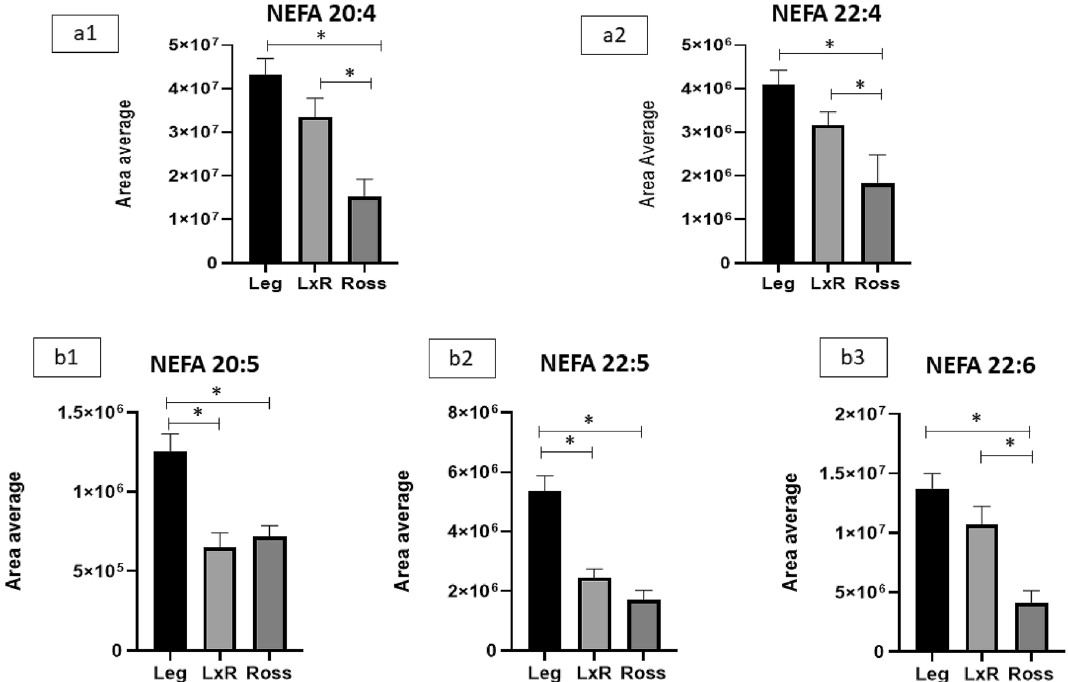
Figure 2. n-6 and n-3 NEFA of chicken liver ( a ) LC PUFA from the n-6 series: NEFA 20:4 (arachidonic acid, ARA, ( a1 ); NEFA 22:4 (adrenic acid, AdA; ( a2 ). ( b ) LC PUFA from the n-3 series: NEFA 20:5 (eicosapentaenoic acid, EPA; NEFA 22:5 (docosapentaenoic acid, DPA; b2 ); FA 22:6 (docosaexaenoic acid, DHA; b3 ). Leg: Leghorn genotype; LxR: crossbreed, Ross: Ross 208 genotype. *P < 0.05 (post hoc Tukey’s